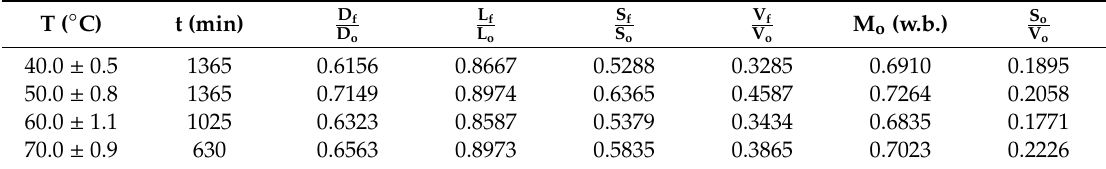
Table 4. Relative shrinkage data longitudinal sliced banana during